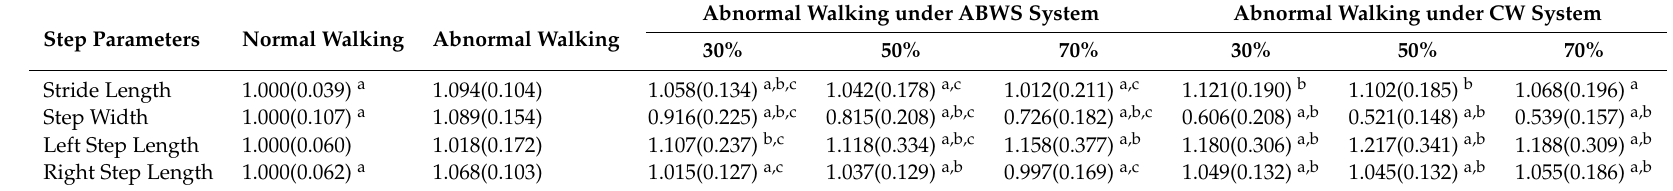
Table 1. The comparison of the standardized values of stride length, step width, the step length of the left and right side. The data of 30s walking in each walking condition of each subject, which was equivalent around 36 gait cycles, was selected. The number of gait cycles in each walking condition is 367 gait cycles for all subjects. The significance level was selected at